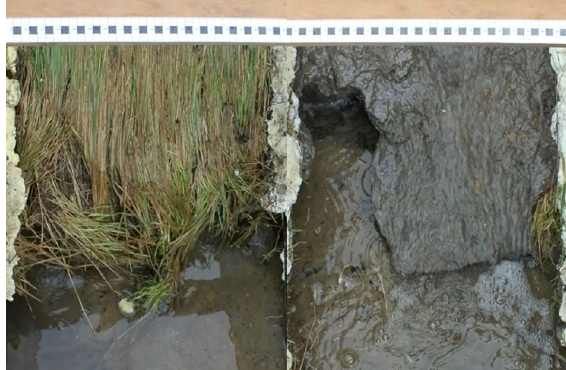
Fig. 17. Dike toe. Clay liner underneath the dike, slip line between the ash/silt dike cover and the clay base. Test section 9 of flume 1 (right) and flume 2 (left) after the 5 th TD